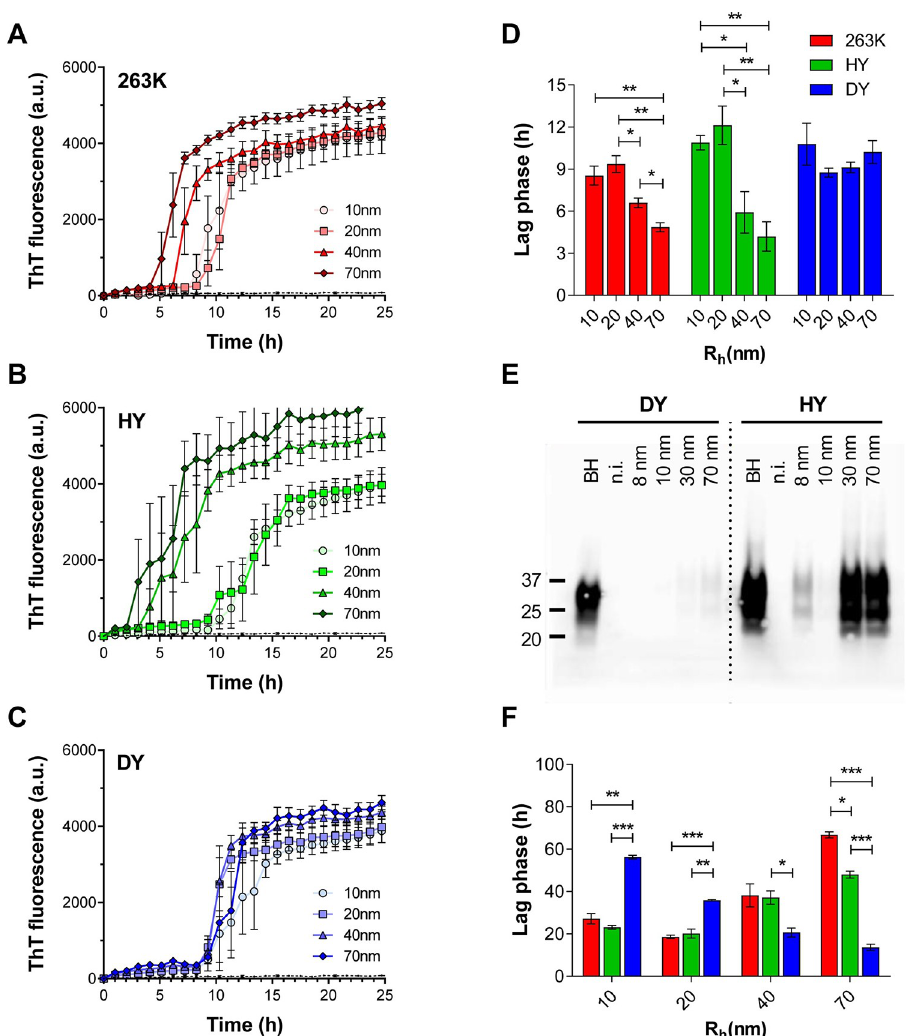
particles of 10 (circles), 20 (squares), 40 (triangles) and 70 (rhombus) nm R h from 263K (A) , HY (B) , and DY (C) are depicted. All aggregation reactions were seeded with the same volume of AF4 fractions. D) Lag phases calculated from the kinetics depicted in A, B, and C. E) Immunoblot for PrP res accumulated in CAD5-PrP − / − (HaPrP) at passage #7 after incubation with AF4 fractions containing particles of 8, 10, 30 and 70 nm R h . Brain homogenate and non-infected cells (n.i.) were used as positive and negative controls. F) Lag phases for the aggregation reactions of recombinant SHaPrP seeded with particles of 10, 20, 40 and 70 nm R h , using the same amount of PrP mass. Data represents average of 3 replicates and error bars represent SE; p-value � � 0.05, �� � 0.01, and ��� �